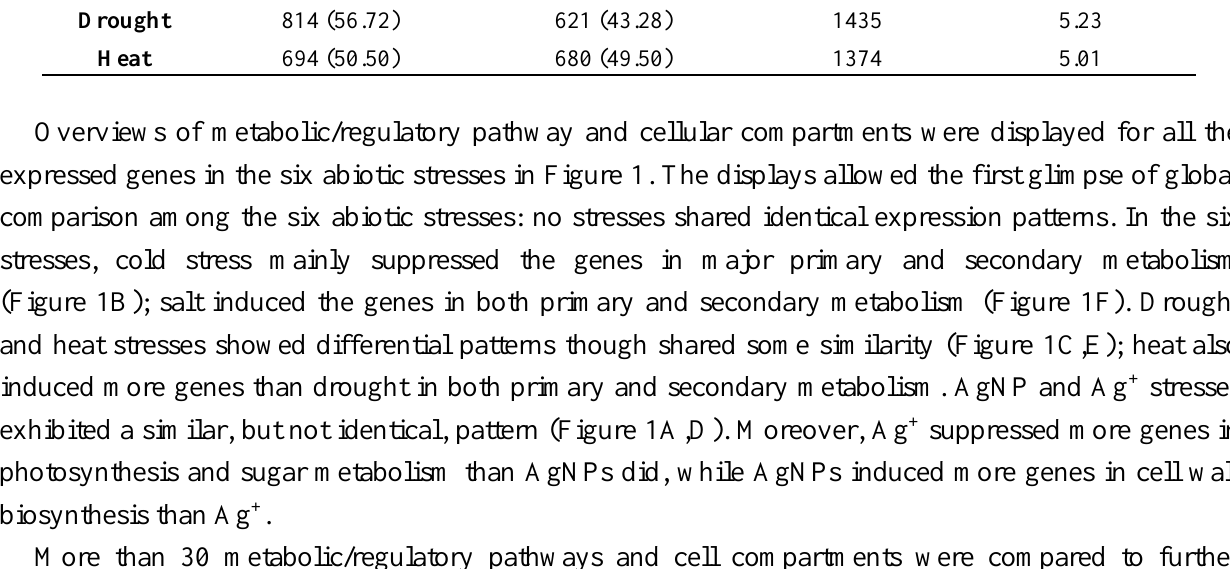
Table 1. The number list of differentially expressed genes that have more than two-fold differences ( i.e ., M ≥ 1 or M ≤ −1) in Arabidopsis thaliana affected by six abiotic stresses, silver nanoparticles (AgNPs), silver ions (Ag + ), cold, salt, drought and heat. % a = regulated gene number/total affected genes. Percentage of total Number of up Number of down Number of total Stress affected genes in regulated genes (% a ) regulated genes (% a ) affected genes genome AgNPs 439 (76.34) 136 (23.65) 575 2.10 Ag + 780 (77.22) 230 (22.77) 1010 3.68 Cold 2514 (38.46) 4022 (61.54) 6536 23.84 Salt 2057 (49.77) 2076 (50.23) 4133 15.08 Drought 814 (56.72) 621 (43.28) 1435 5.23 Heat 694 (50.50) 680 (49.50) 1374